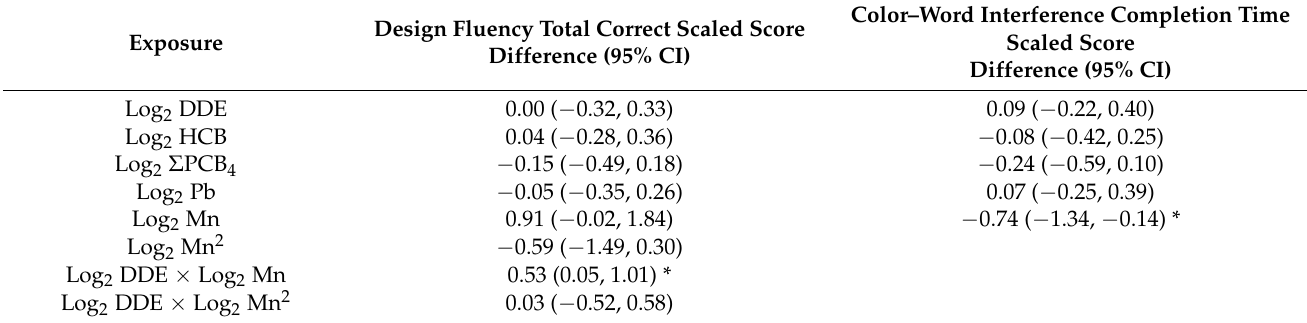
Table 2. Complete-case results of multivariable linear regression analyses (difference in scaled scores associated with a twofold increase in exposure and 95% CI) 1 assessing the relation of prenatal exposure to a five-chemical mixture with Delis–Kaplan Executive Function System inhibition scaled scores among adolescents in the main analysis group 2 .